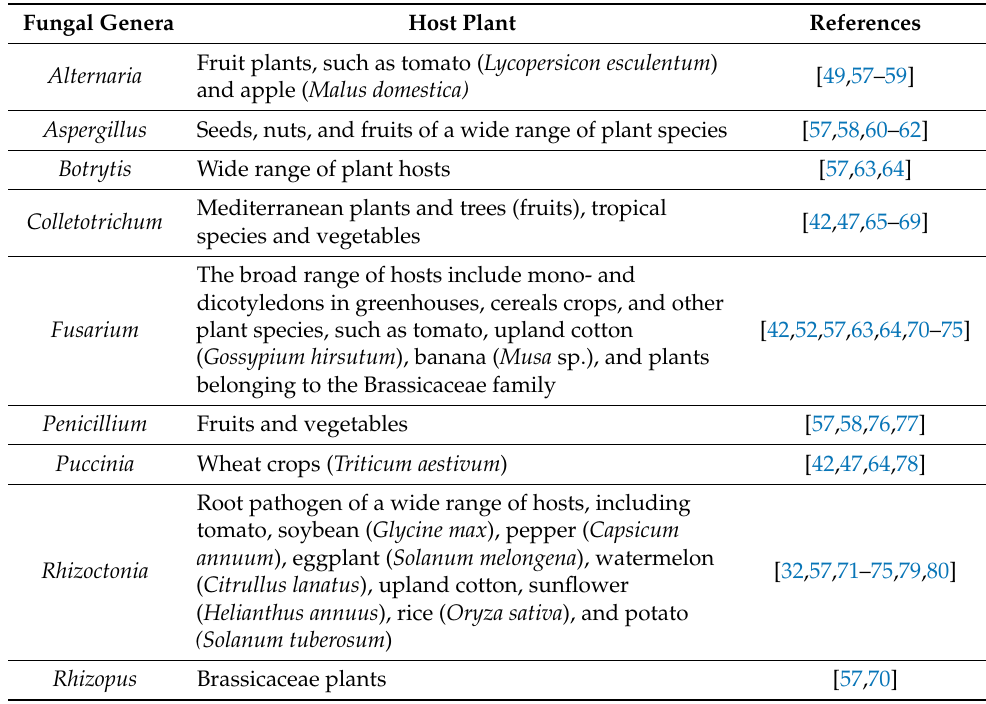
Table 1. Relevant phytopathogenic fungi genera and their